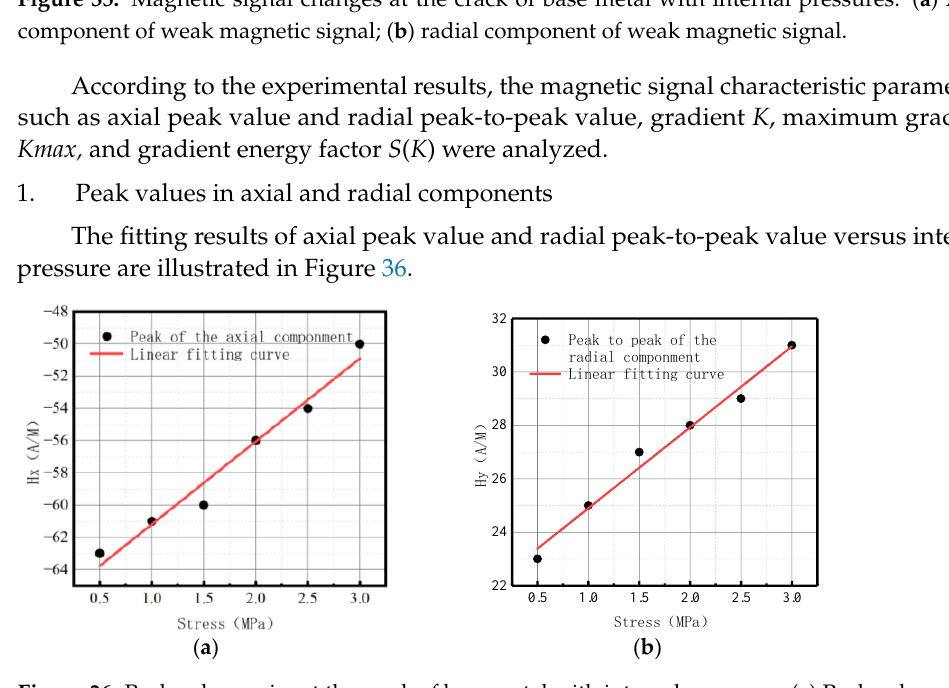
Figure 35. Magnetic signal changes at the crack of base metal with internal pressures. ( a ) Axial component of weak magnetic signal; ( b ) radial component of weak magnetic signal.